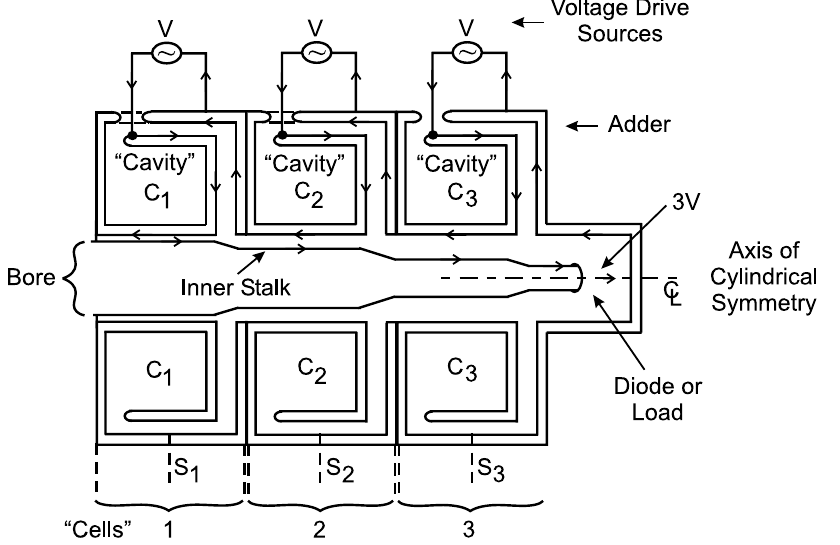
FIG. 1. The induction voltage adder (three stage). Schematic shows that the current path (indicated by arrows) connects the voltage sources directly in series with the